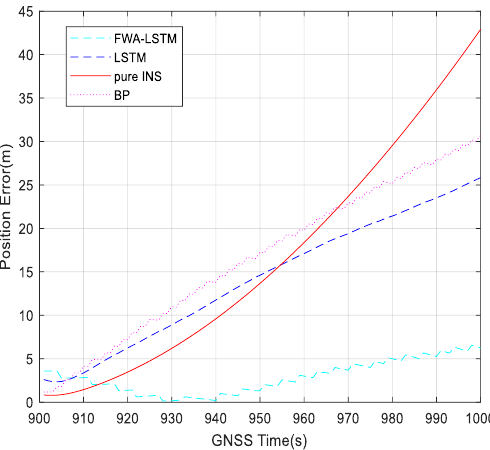
Figure 16. Position errors during 900~1000 s with different algorithms.